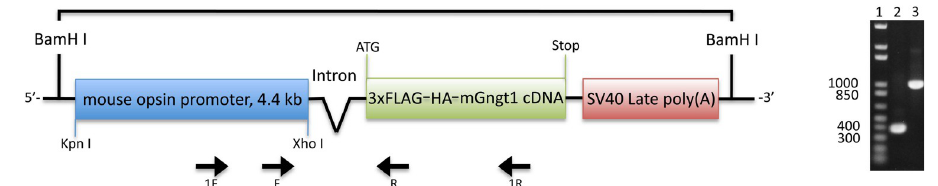
Fig 2. G γ 1 transgenic construct (left) and the PCR screening test (right). DNA gel: 1) Molecular weight markers; 2) 349 bp PCR product using universal F/R primers; 3) 1011 bp PCR product using 1F/1R primers. Similar design was employed to generate G γ c and G γ 11 transgenic